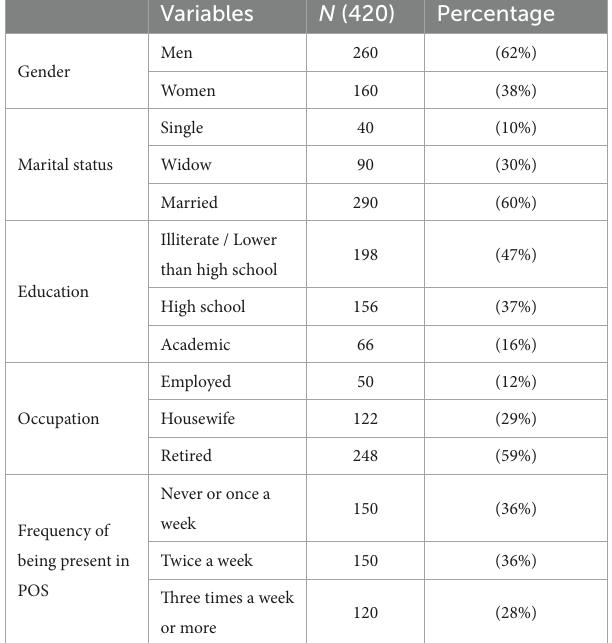
TABLE 1 Descriptive characteristics of the study participants ( n =